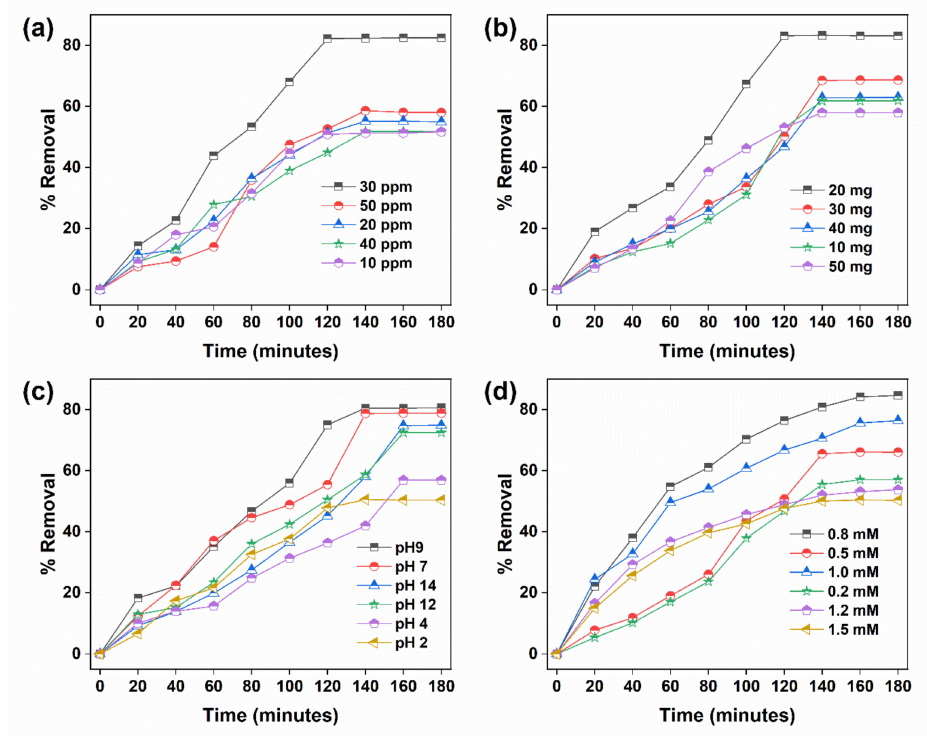
Figure 4. Parameters for the remediation of CVD: ( a ) the concentration of crystal violet, ( b ) the effect of GA-cl-poly(acrylamide)@C 3 N 4 /BiOI nanocomposite hydrogel dosage, ( c ) the effect of pH, and ( d ) the effect of H 2 O 2